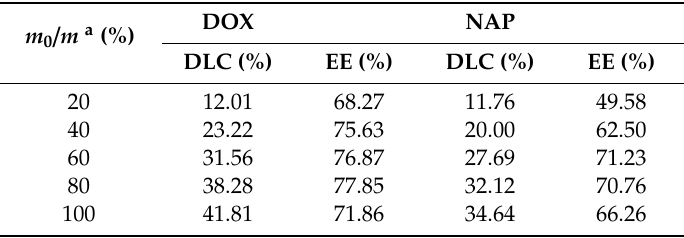
Table 2. The drug-loading content (DLC%) and entrapment efficiency (EE%) of the nanoparticles for DOX and NAP.